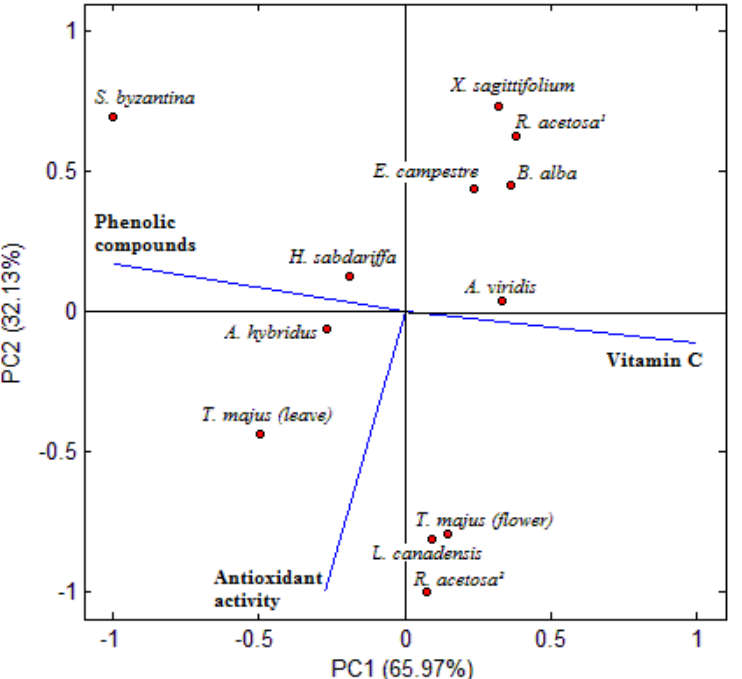
Figure 1 - Analysis of the main components related to the observed results for antioxidant activity, vitamin C and phenolic